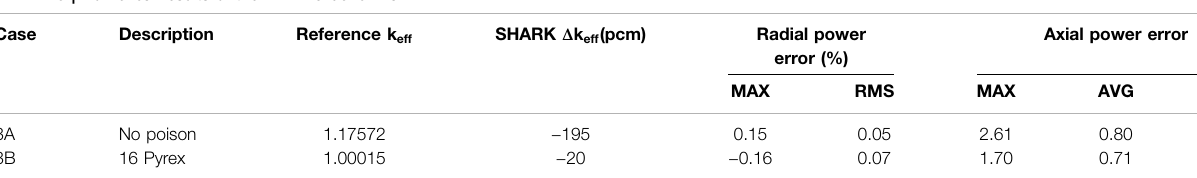
TABLE 3 | Numerical results of the VERA-3 benchmark.